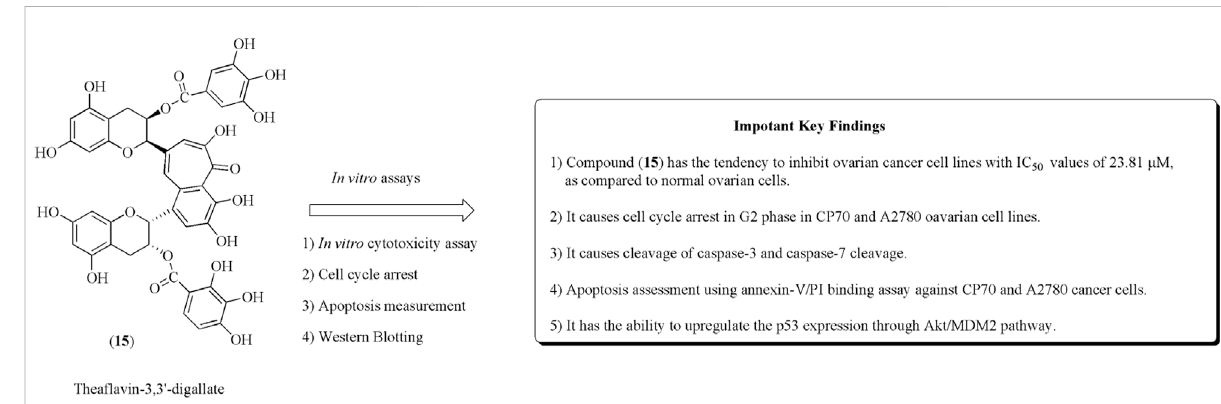
FIGURE 19 Structure of compound (15) along with its mechanistic insights. CP70 and A2780 cell lines were used.